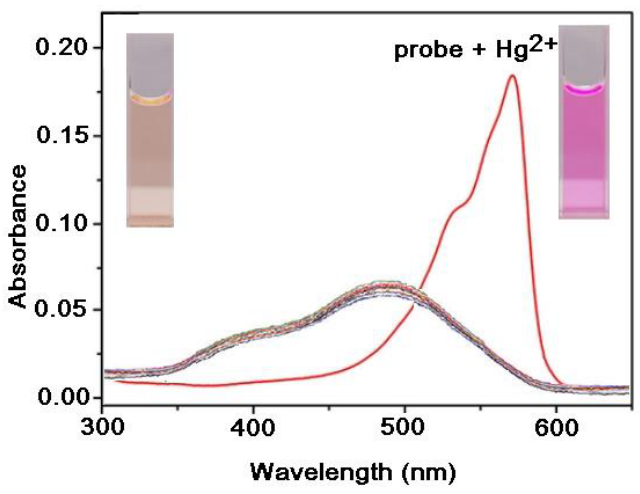
Figure 5. Absorption spectra of VRF probe (10 μ M) in the presence of Hg 2+ and other metal ions (100 μ M) in CH 3 CN/HEPES buffer solution (1:1, v / v , 0.1 M, pH = 7.4). Inset: the change in the colour of VRF in the absence and presence of Hg 2+ (colourless to pink).